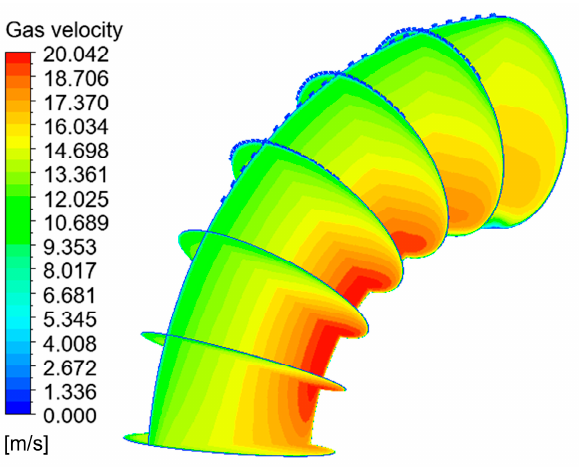
Figure 15. Velocity distribution and streamline of the gas phase.